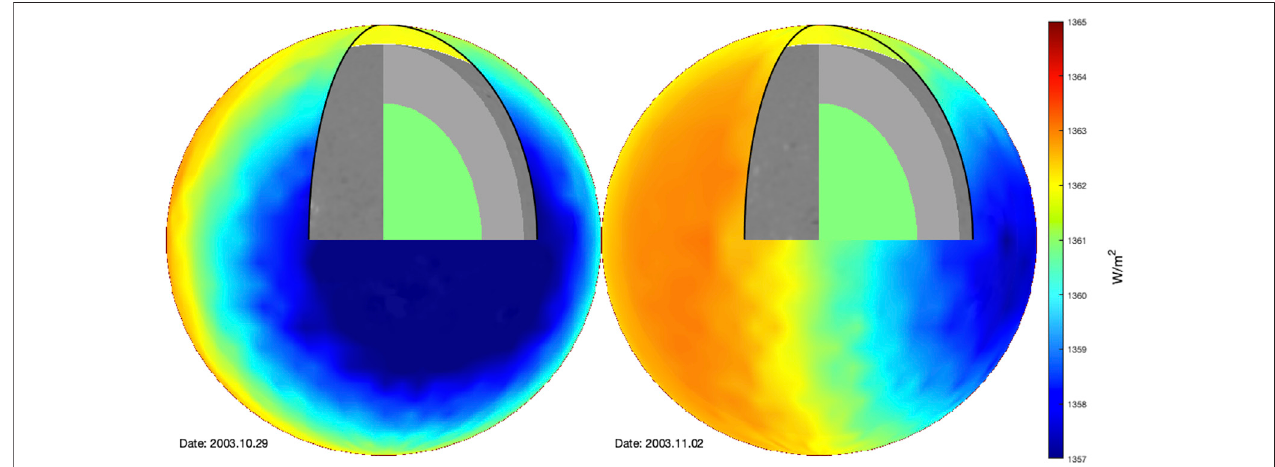
FIGURE 3 | Sun ’ s outward radiative fl ux reconstruction by extending irradiance for a spherical shell simulated at 1 AU using the fl ux dispersal model for the photospheric magnetic fi eld. The cutout represents the solar surface (gray sphere), the convection zone (gray radial surface), and the radiative zone + core (green radial surface).